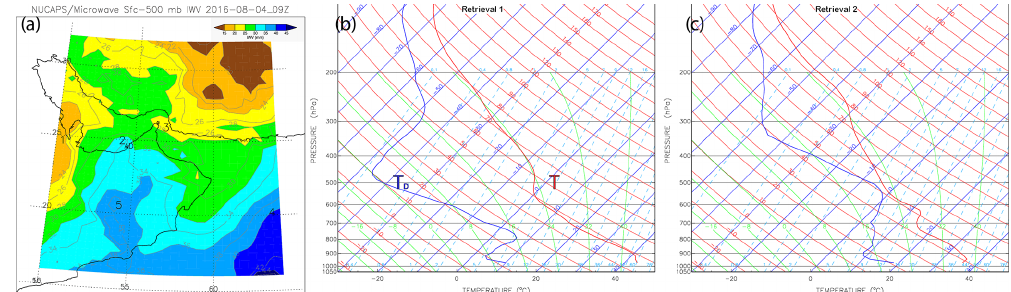
Figure 9. NUCAPS-derived integrated water vapor between the surface and 500hPa (a) valid on 4 August 2016 at 09:21UTC, and profiles of temperature ( T ) and dew point temperature ( T D ) at two selected locations: (b) the dry air mass (location 1, west of Qatar) and (c) moist air mass (location 2, offshore of UAE in the SG). Panel (a) shows large differences ( ∼ 15–20mm) in low- to mid-level moisture in the regions represented by the two soundings.